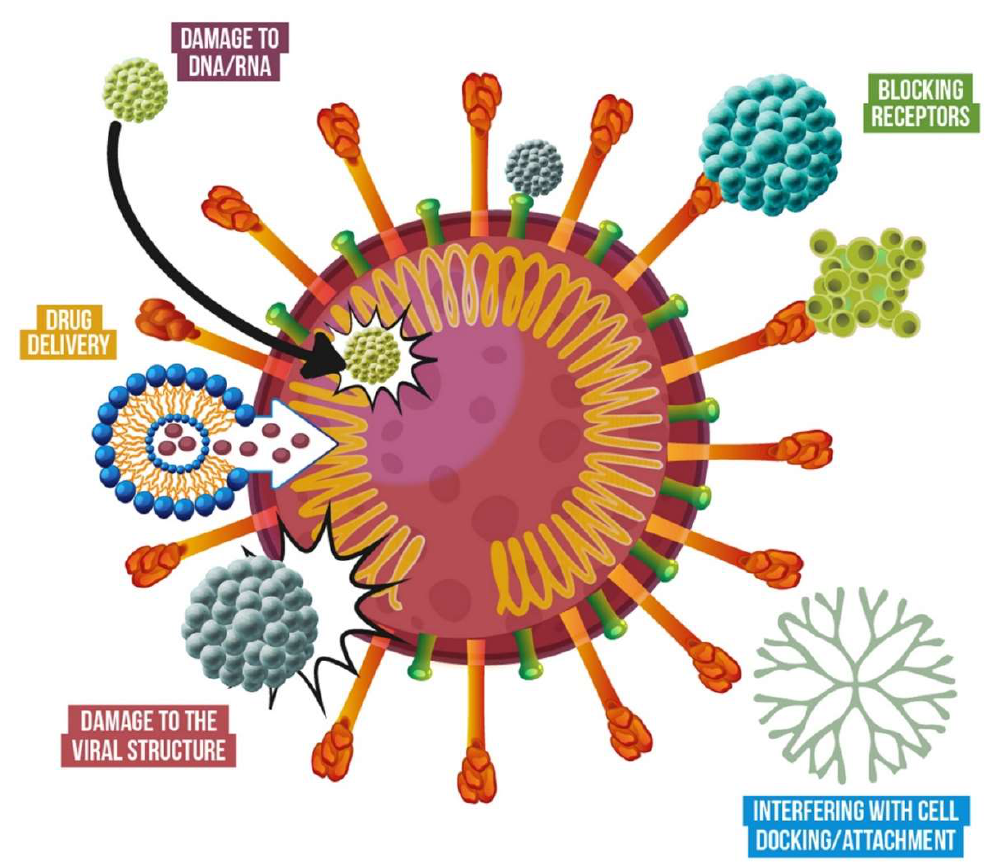
Figure 2. Proposed antiviral mechanisms that nanoparticles use to deactivate viruses.